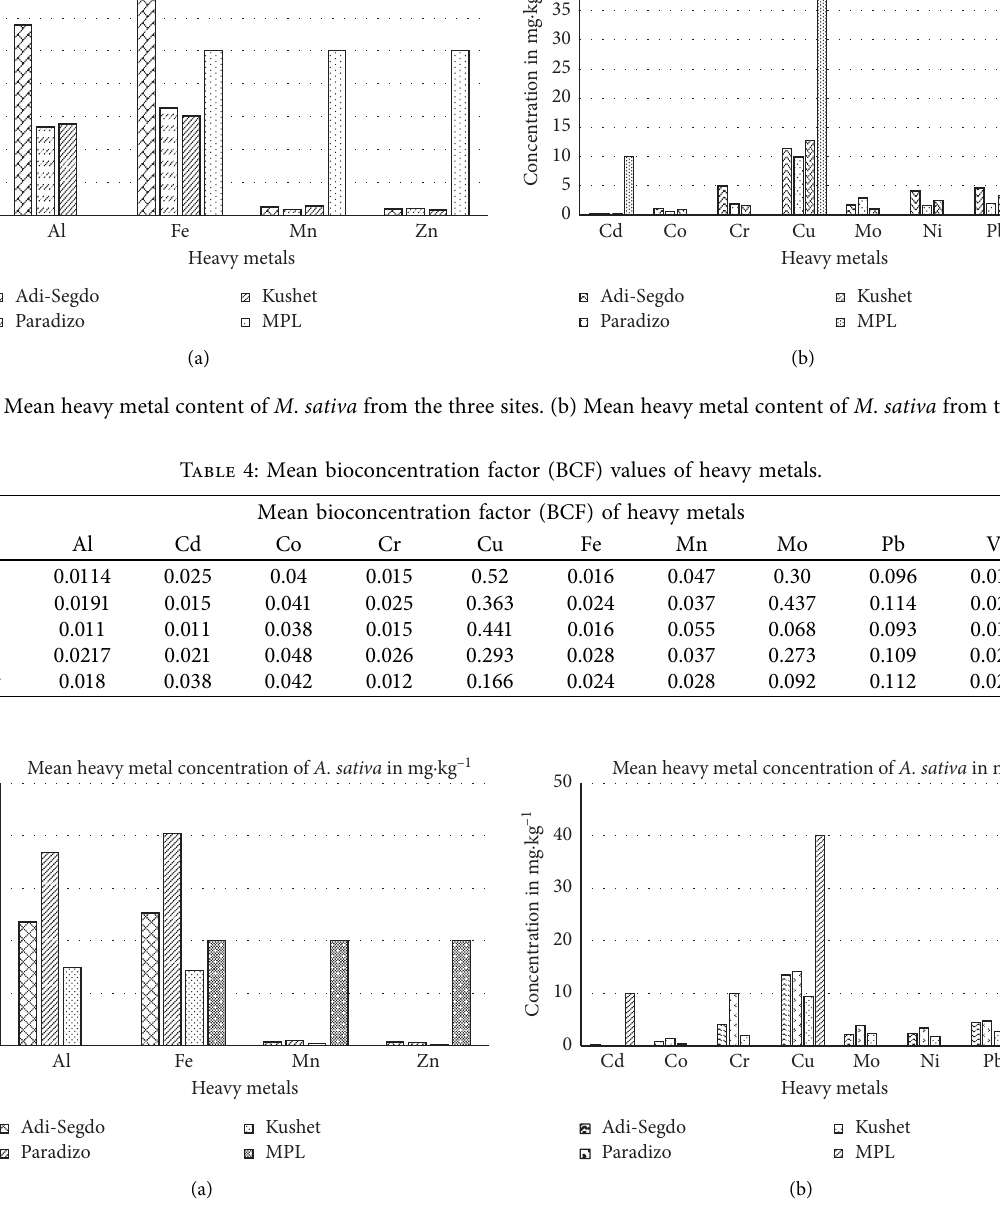
Figure 3: (a) Mean heavy metal content of A . sativa from the three sites. (b) Mean heavy metal content of A . sativa from the three